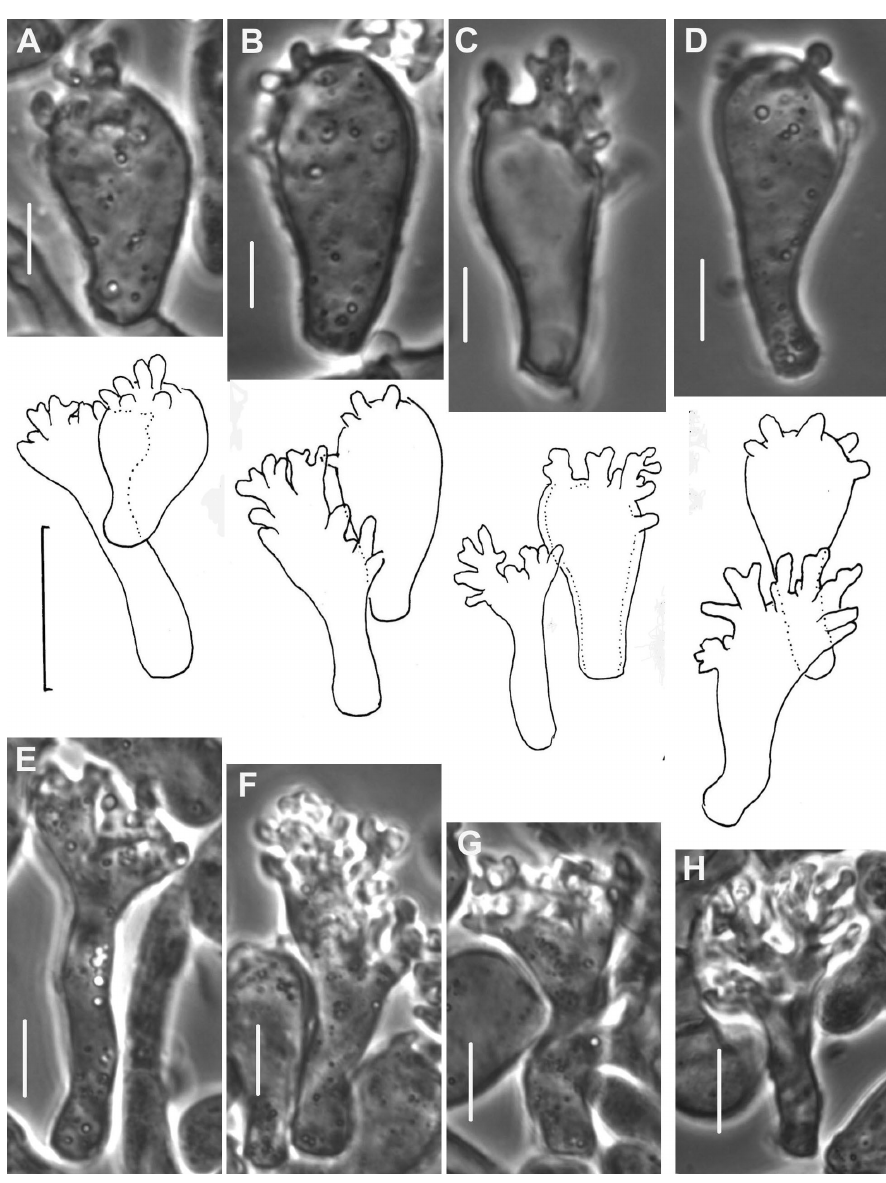
Figure 79. Mycetinis scorodonius f. diminutivus . Pileipellis elements from pileus margin. A–D Thick- walled, inflated elements with diverticula E–H Arbuscular pileocystidia. Outlines furnished to better interpret photographs. Standard bars = 10 µm. WTU